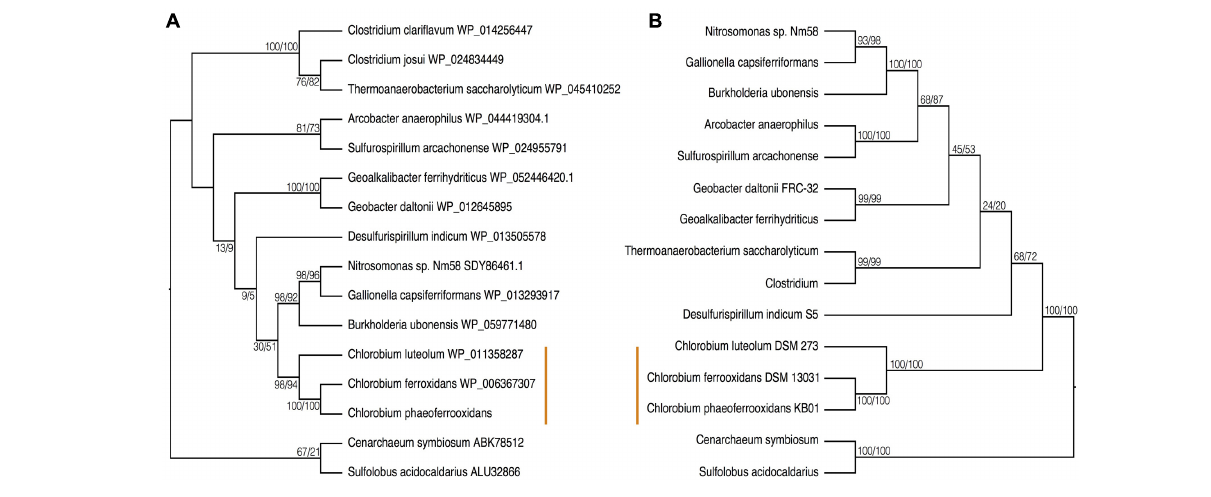
FIGURE 6 | Phylogenies of (A) the CysH protein and (B) 16S rRNA with bootstrap values shown at each node (maximum likelihood/maximum parsimony). The orange line indicates the position of the photoferrotrophic Chlorobi. The trees are rooted with two Archaeal